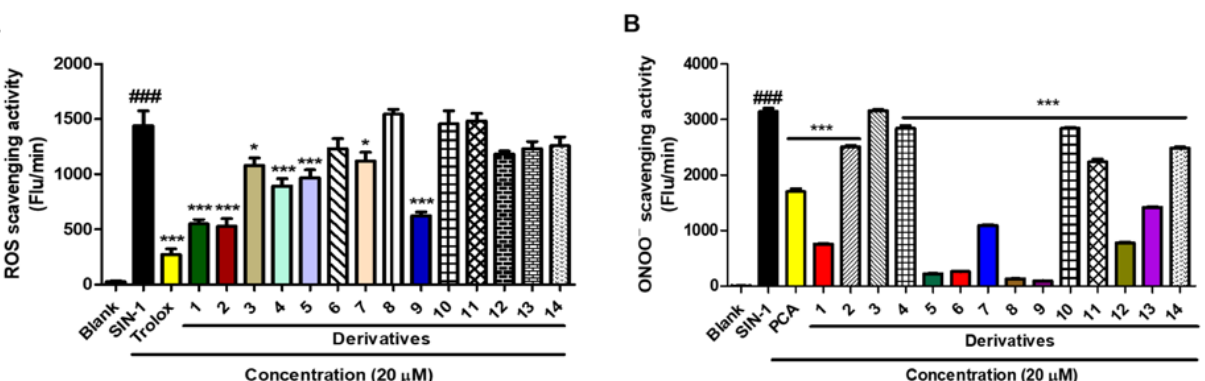
Figure 12. Effects of BABT derivatives 1 – 14 on the scavenging activities of reactive oxygen species (ROS) ( A ) and peroxynitrite ( B ). For the ROS scavenging activity experiment, 3-morpholinosydnonimine (SIN-1) and Trolox were used as the ROS generator and positive reference material, respectively, and for the peroxynitrite scavenging activity experiment, SIN-1 and penicillamine (PCA) were used as the peroxynitrite generator and positive reference material, respectively. In both experiments, all test samples were used at 20 µ M, and each experiment was performed independently, thrice. Results are represented as the mean ± SEM of three independent experiments. Symbols (* and # ) indicate the significant differences between columns. ### p < 0.001 for SIN-1-treated cells vs. untreated control; *** p < 0.001, * p < 0.05 for SIN-1 plus Trolox, penicillamine, or BABT derivative-treated group vs. SIN-1-treated